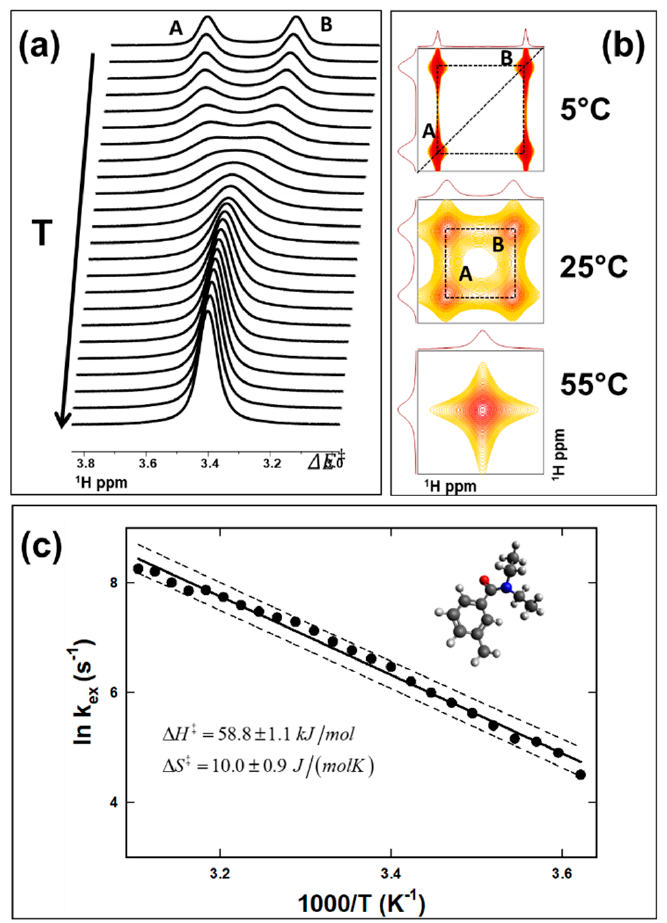
Figure 2. Intramolecular exchange and thermodynamics of N, N-diethyl-m-toluamide ( m -DEET). ( a ) Spectral changes corresponding to an intramolecular exchange between two sites as a function of sample temperature, ( b ) exchange-correlation spectroscopy (EXSY) spectra of m -DEET at three different temperatures. In ( a ) and ( b ), the two sites are marked as ‘A’ and ‘B.’ ( c ) Eyring plot used to determine the activation enthalpy and entropy, and the k ex was estimated using the line shape analysis from the panel ( a ). The insert in panel ( c ) shows the molecular structure of m -DEET. Figure reproduced with permission [31].